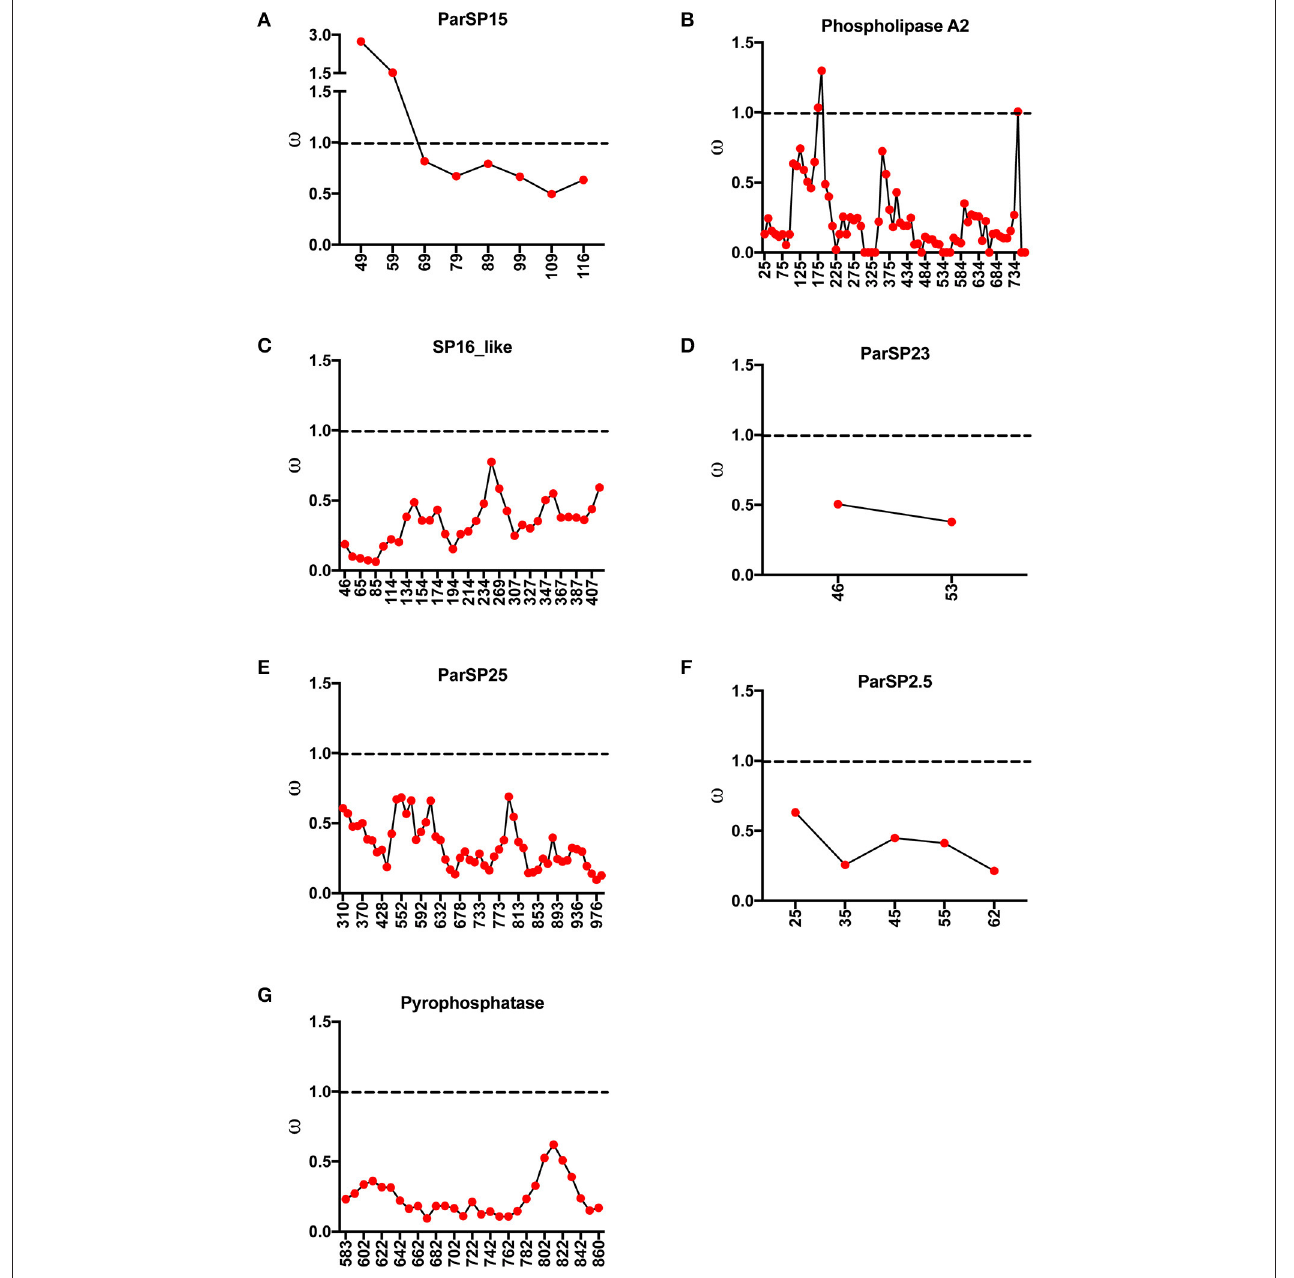
FIGURE 4 | Slide window analyses of omega ( ω ) for the salivary protein families unique to Old World sand flies. Dotted lines point to the threshold for positive selection ( ω ≥ 1). (A) ParSP15. (B) Phospholipase A2. (C) SP16. (D) ParSP23. (E) ParSP25. (F) ParSP2.5. (G) Pyrophosphatase.